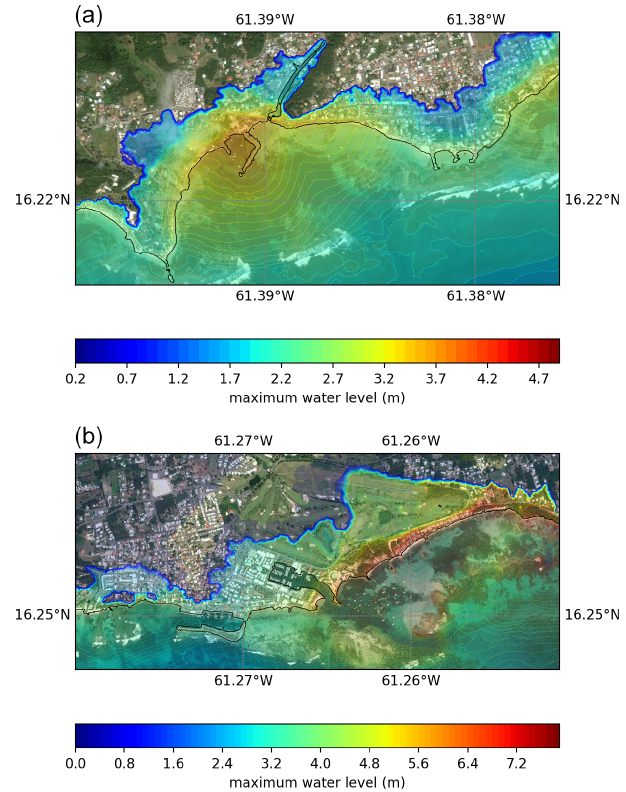
Figure 23. Flood map showing the maximum water level reached during the 80km 3 scenario for the region of Sainte-Anne (a) and Saint-François (b) (see locations in Fig. 6) computed by SCHISM. Map created using ArcGIS ® software by Esri. ArcGIS ® and Ar- cMap™ are the intellectual property of Esri and are used herein under license. Copyright © Esri. All rights